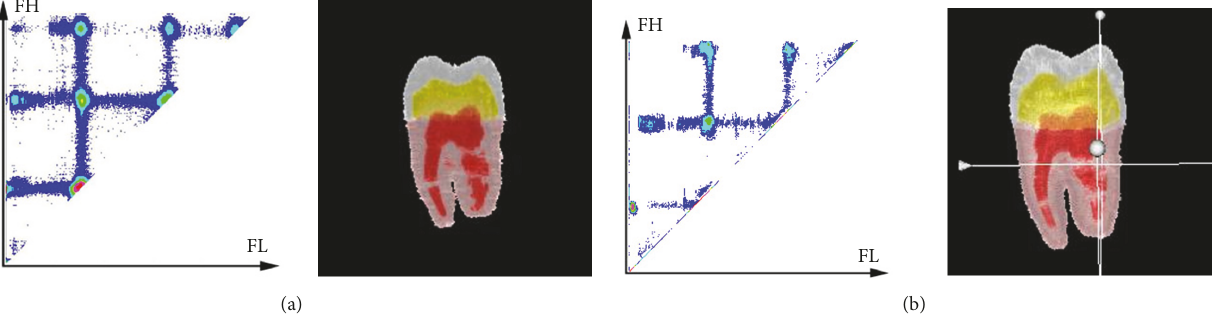
Figure 4: LH histogram and corresponding rendering result with nonlinear enhanced tooth dataset through the conventional and region criteria based method: (a) LH histogram based on conventional method with gradient threshold of 5 and the corresponding rendering result and (b) LH histogram based on region criteria based method and the rendering result.